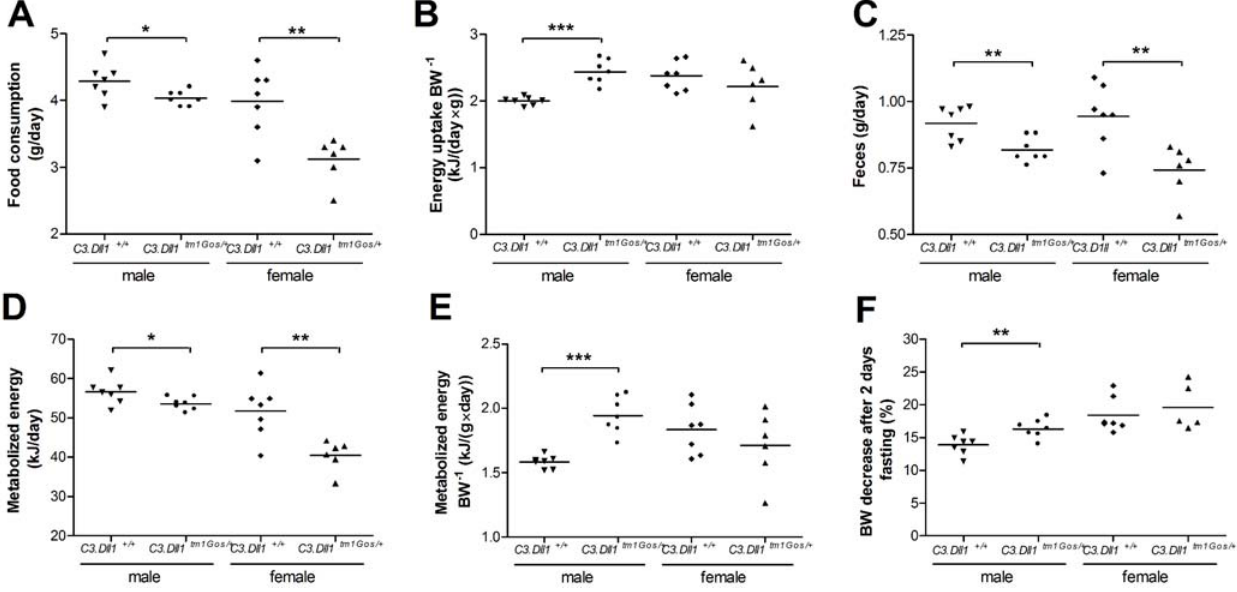
Figure 2. Metabolic parameters collected from heterozygous C3.Dll1 tm1Gos/ + animals and their wild-type littermates at the GMC. A–E) Values were recorded during 2 weeks ad libitum feeding. F) Body weight decrease (%) after two days fasting. Depicted are the scatter dot plot representations and the mean for each group: heterozygous C3.Dll1 tm1Gos/ + males (n=7) and their wild-type littermates ( C3.Dll1 + / + , n=7); heterozygous C3.Dll1 tm1Gos/ + females (n=6) and their wild-type littermates ( C3.Dll1 + / + , n=7). P -value calculated performing unpaired t-test when variances were not significantly different. If significantly different then the Mann-Whitney test was performed. P -value: * P , 0.05, ** P , 0.01, *** P , 0.001. doi:10.1371/journal.pone.0006054.g002 PLoS ONE |